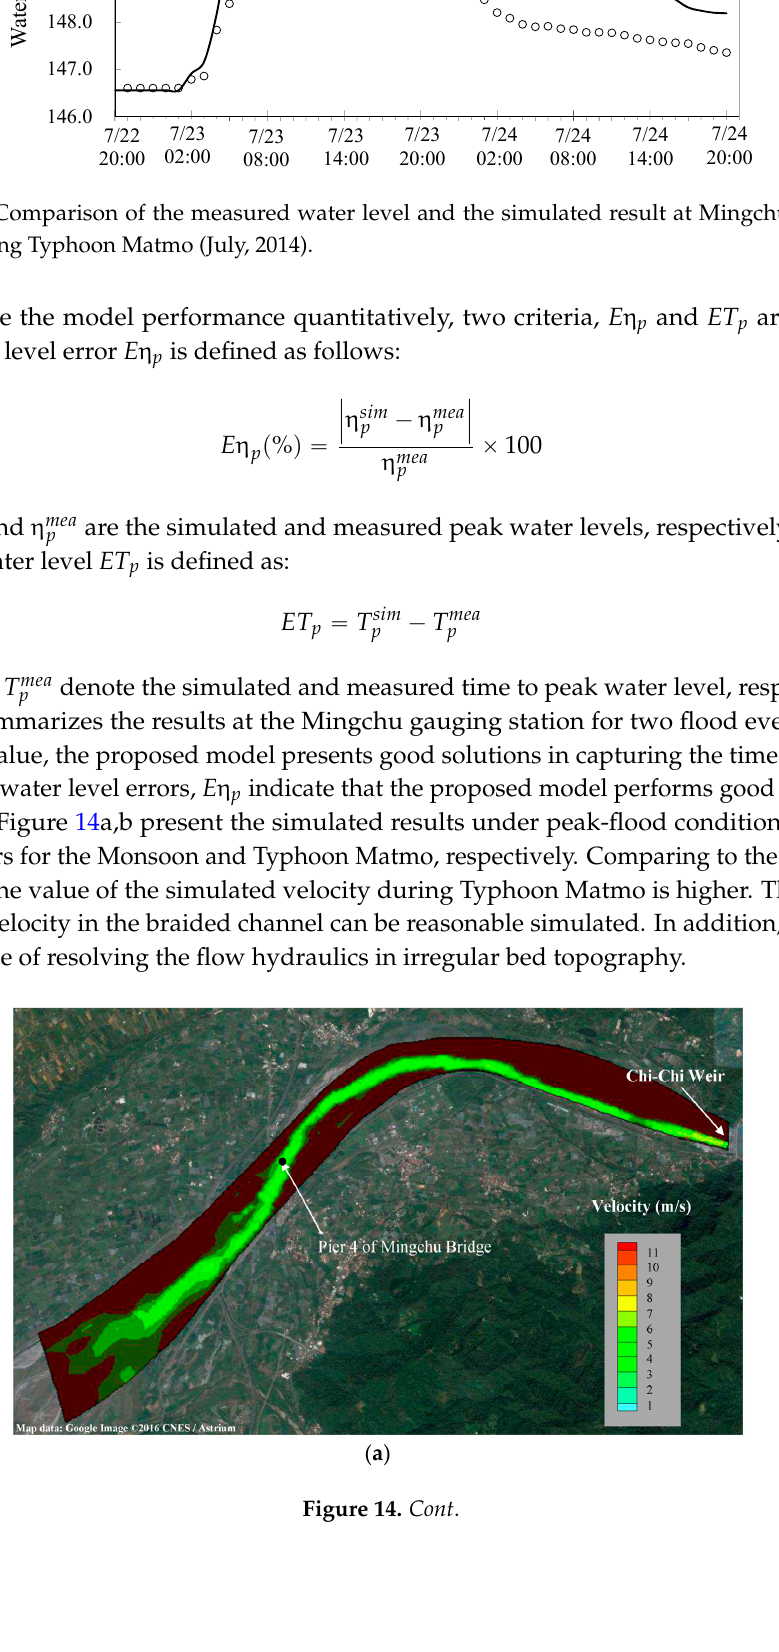
Figure 13. Comparison of the measured water level and the simulated result at Mingchu gauging station during Typhoon Matmo (July,